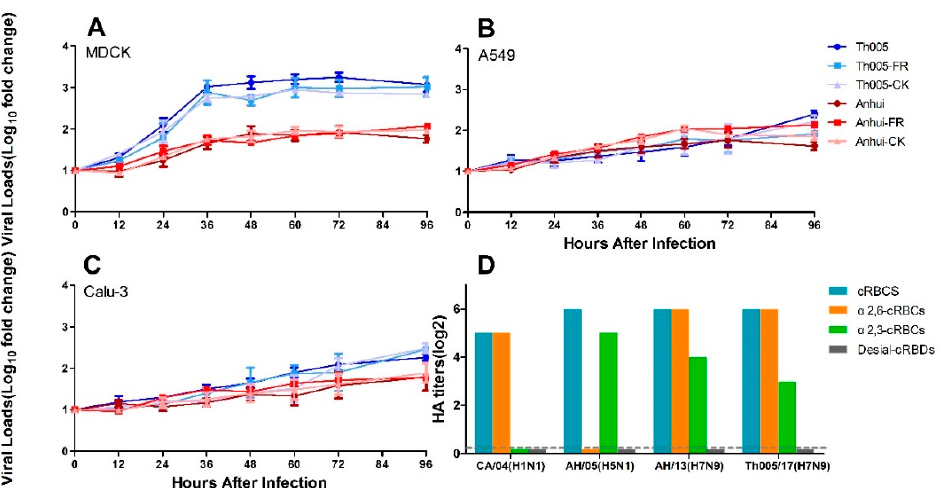
Figure 5. Growth replication curves and viral receptor-binding characteristics of Th005, Th005 FR, Th005 CK, Anhui, Anhui FR, and Anhui CK. ( A ) MDCK cells, ( B ) A549 cells, and ( C ) Calu-3 cells. ( D ) Viral receptor-binding characteristics: cRBCs, untreated chicken red blood cells. α 2,6-cRBCs, removal of α 2,3 sialic acid protein on the surface of chicken red blood cells by α 2,3-sialidase. α 2,3-sRBCs, sheep red blood cells containing only α 2,3 sialic acid protein. Desialidated cRBCs, VCNA-treated chicken red blood cells with removal of proteins containing α 2,3 and α 2,6 sialic acid.